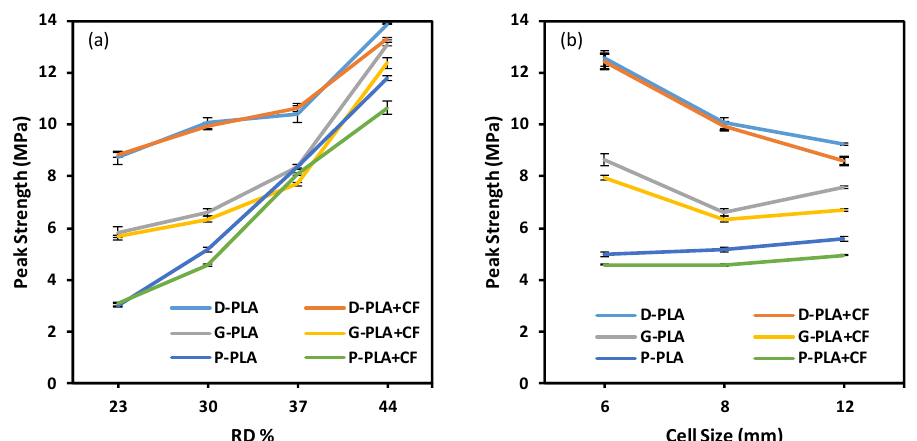
Figure 11. Peak strengths of the Diamond, Gyroid, and Primitive structures at ( a ) RDs while cell size remained at 8 mm and ( b ) different cell sizes while RD% remained at 30%.